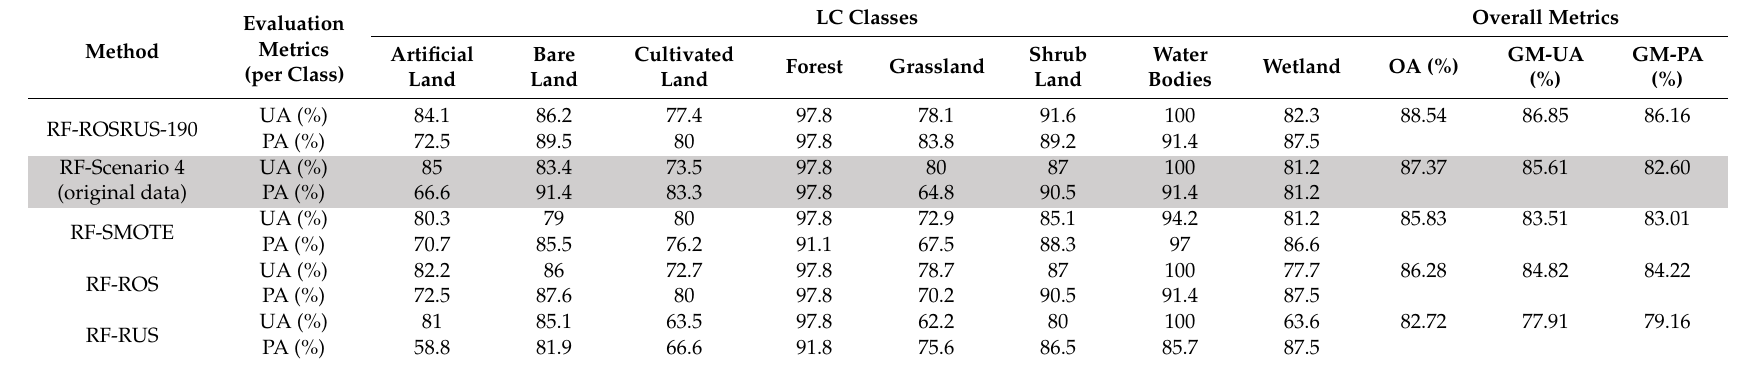
Table A3. Accuracy assessment of the four data balancing methods and traditional RF (Scenario-4) over Site-1.